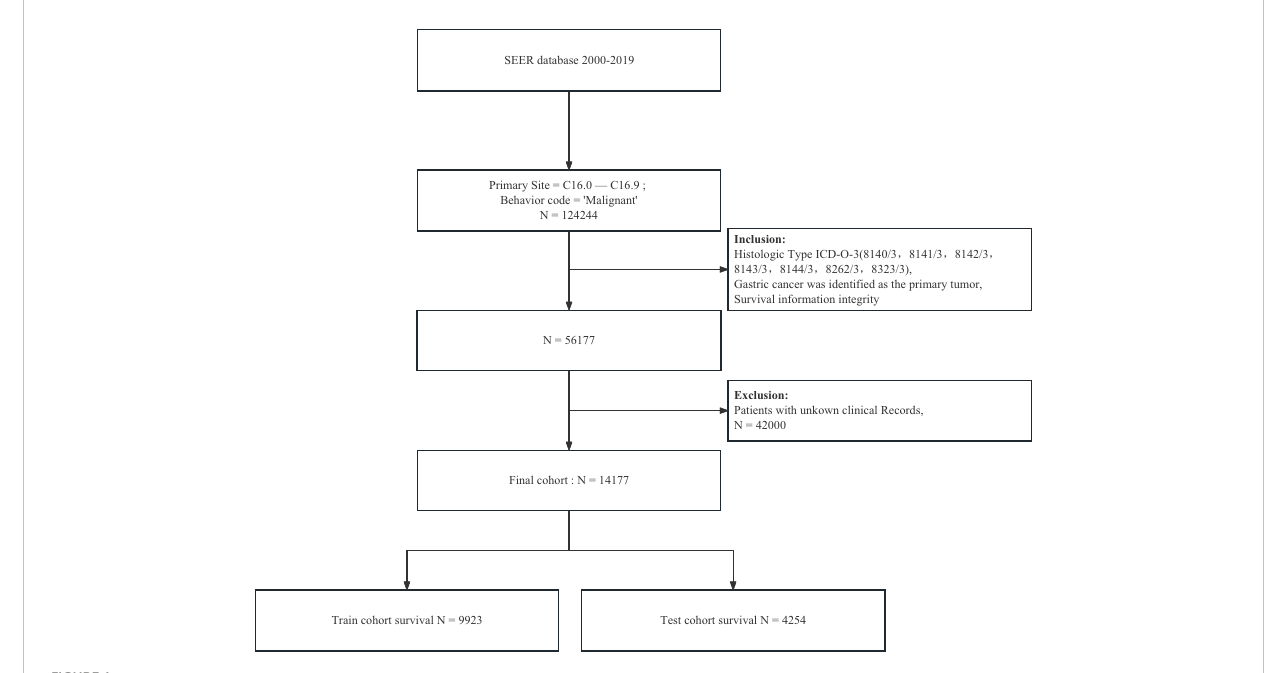
FIGURE 1 The fl ow diagram of patients with gastric adenocarcinoma